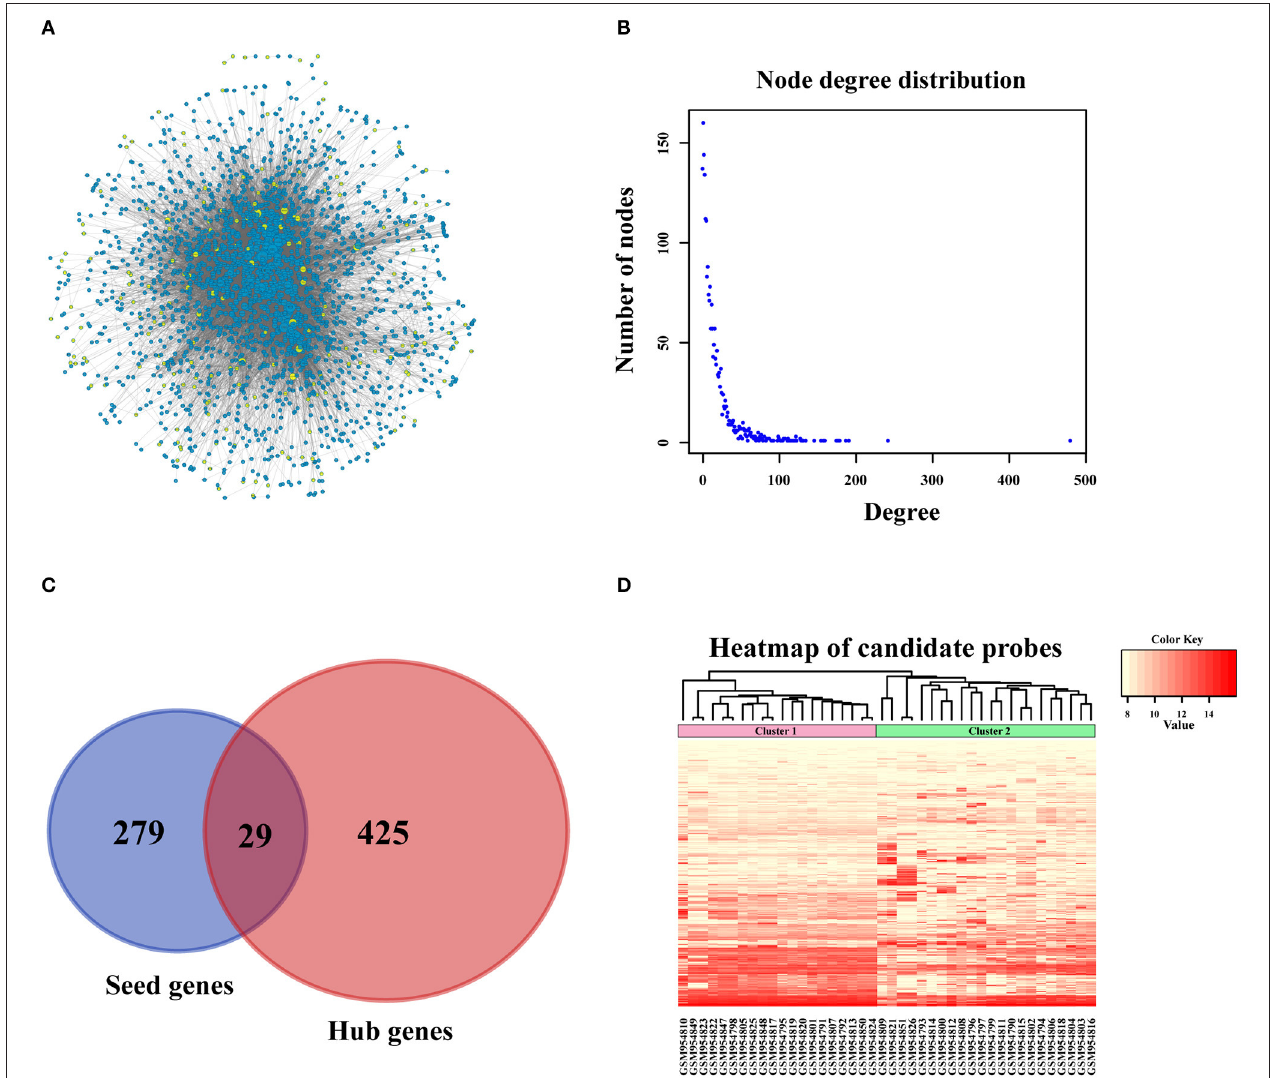
FIGURE 3 | PPI network construction. (A) Sub-network of candidate genes. Three hundred and eight seed genes were subjected into PPI network and 192 nodes were obtained. The above nodes and its closest neighbor genes were extracted to construct sub-network containing 2,270 nodes. (B) The distribution of interacted nodes. (C) The venny gram of seed genes and hub genes. (D) The expression heatmap of all candidate